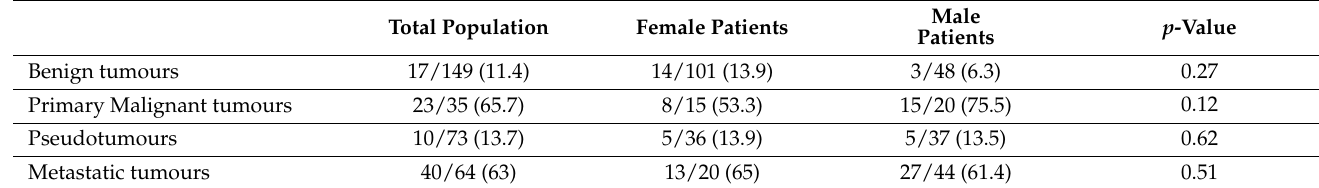
Table 6. Univariate and multivariable logistic regression model showing the clinical predictors of death during follow up in patients with Cardiac Masses.